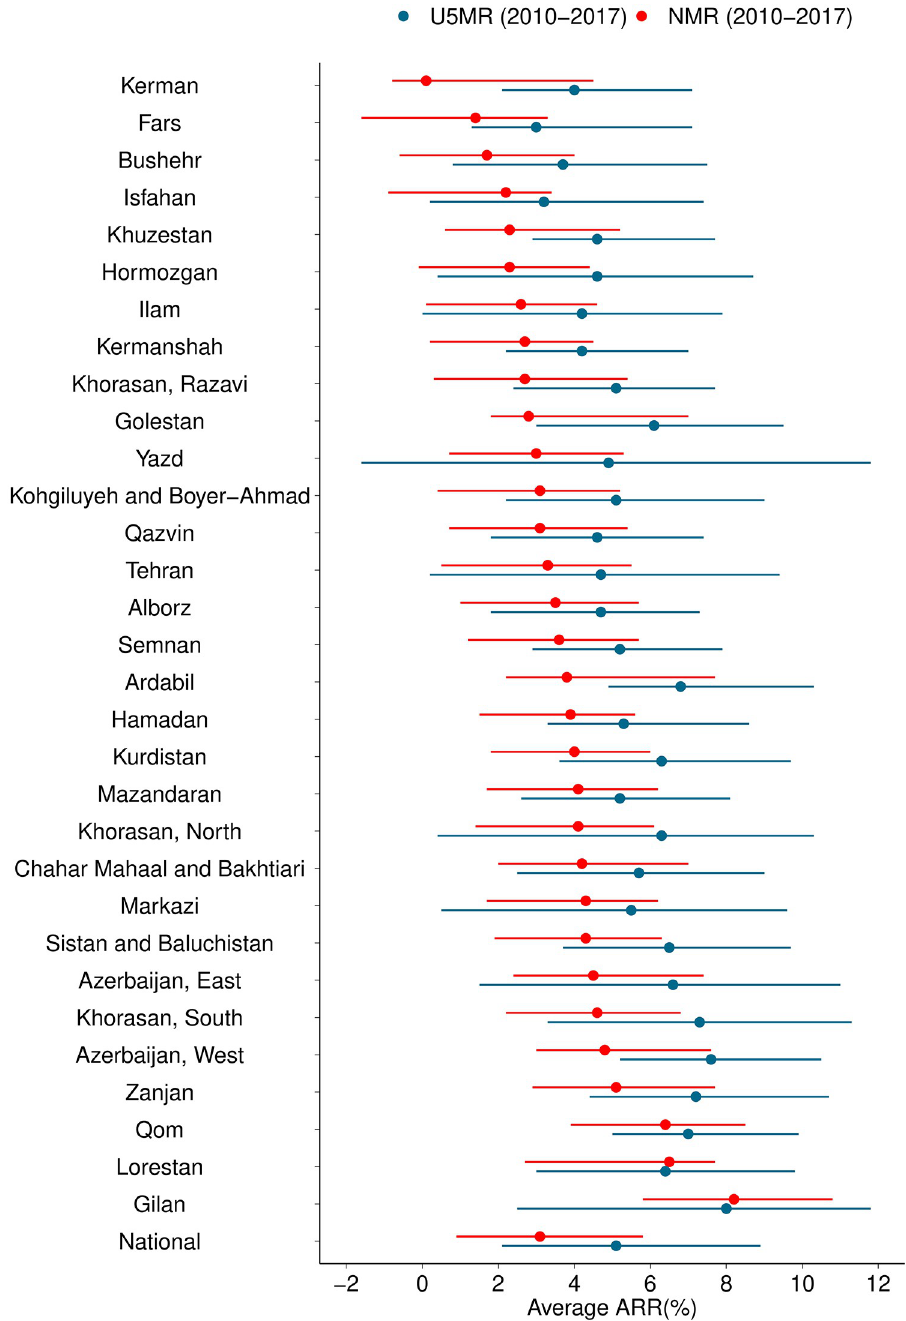
Fig 3. National and provincial U5M-ARRs and NM-ARR between 2010 and 2017.